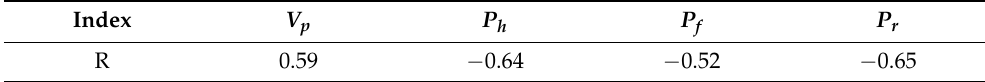
Table 5. Correlation coefficients between the surrounding rock grade and each drilling parameter.